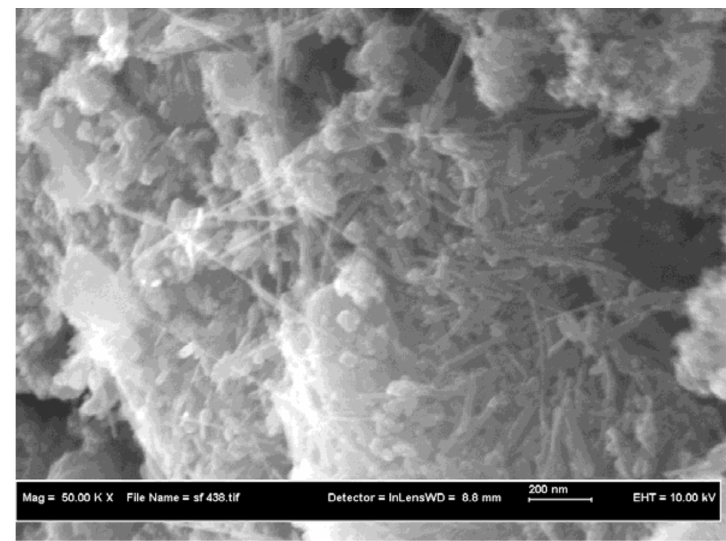
Figure 11. Agglomeration of the MWCNTs with other carbon nanomaterials synthesized in Ar ambient at 1 mbar pressure.